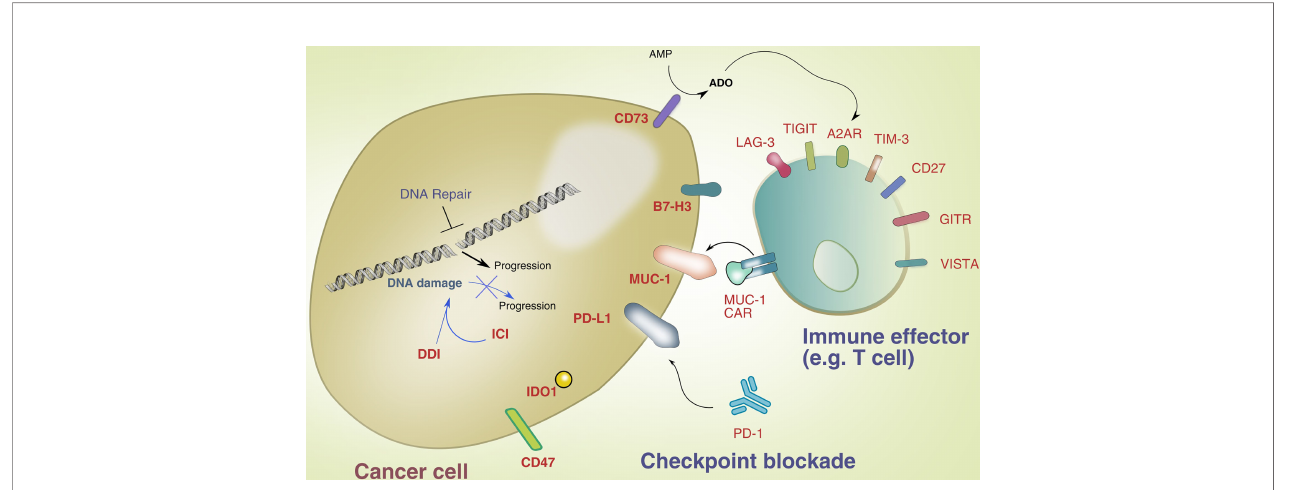
FIGURE 1 | Novel immunotherapy targets and intersection with DNA